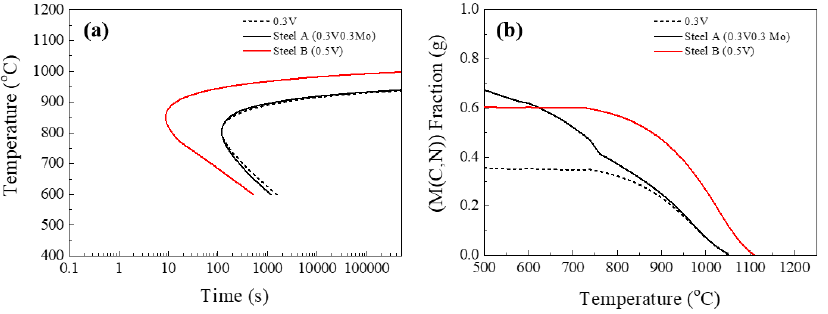
Figure 6. ( a ) Time-temperature-precipitation (TTP) and ( b ) precipitate fraction diagram of different V and Mo composition, as calculated using J-MatPro software.